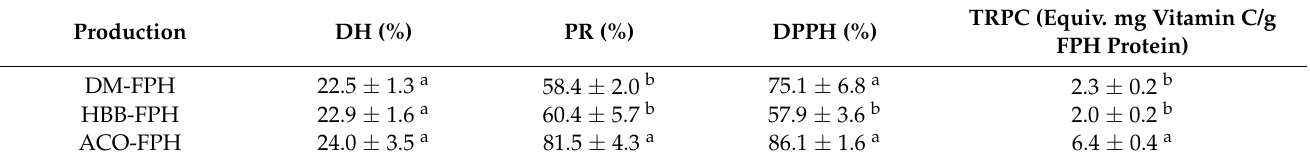
Table 3. Efficiency of the fish protein hydrolysate (FPH) production from fish protein isolates